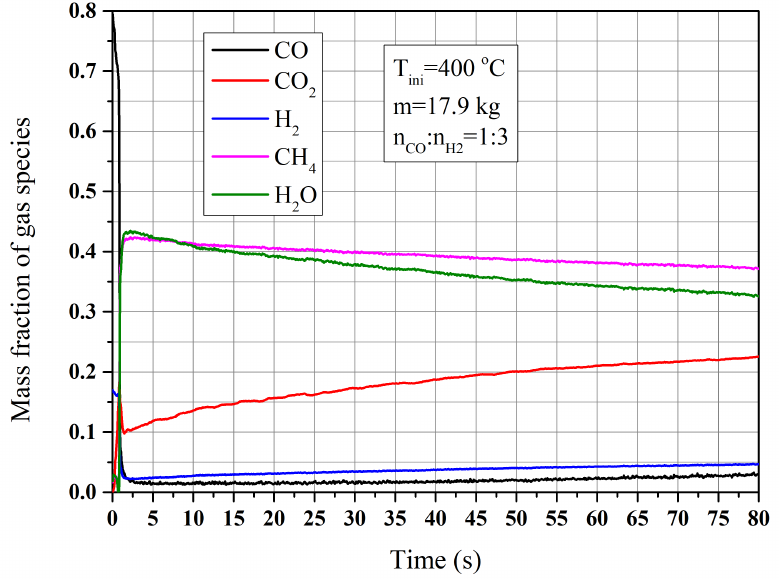
Figure 7. Time-evolution of mass fraction of gas species at outlet. Initial temperature is 400 ◦ C. Gas inlet rate is 0.018 kg/s. Solid inventory is 17.9